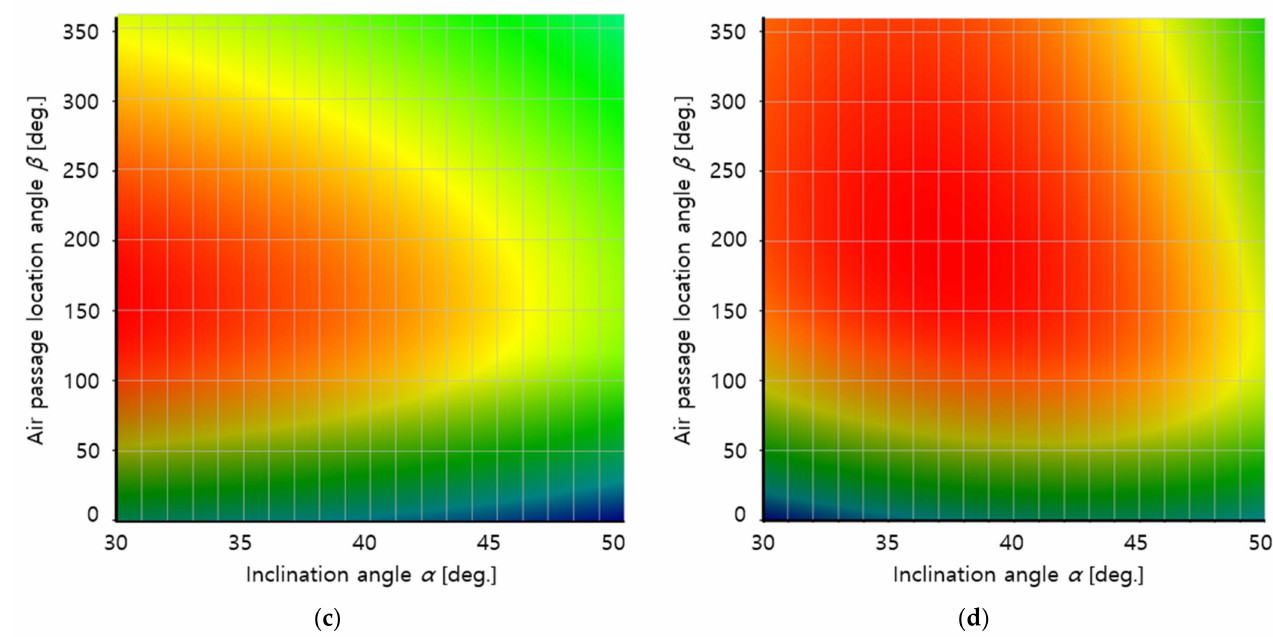
Figure 10. Overall pre-cleaner efficiency η according to change in design variables α and β : response surfaces at ( a ) 4500 rpm and ( b ) 6000 rpm and response planes at ( c ) 4500 rpm and ( d ) 6000 rpm.